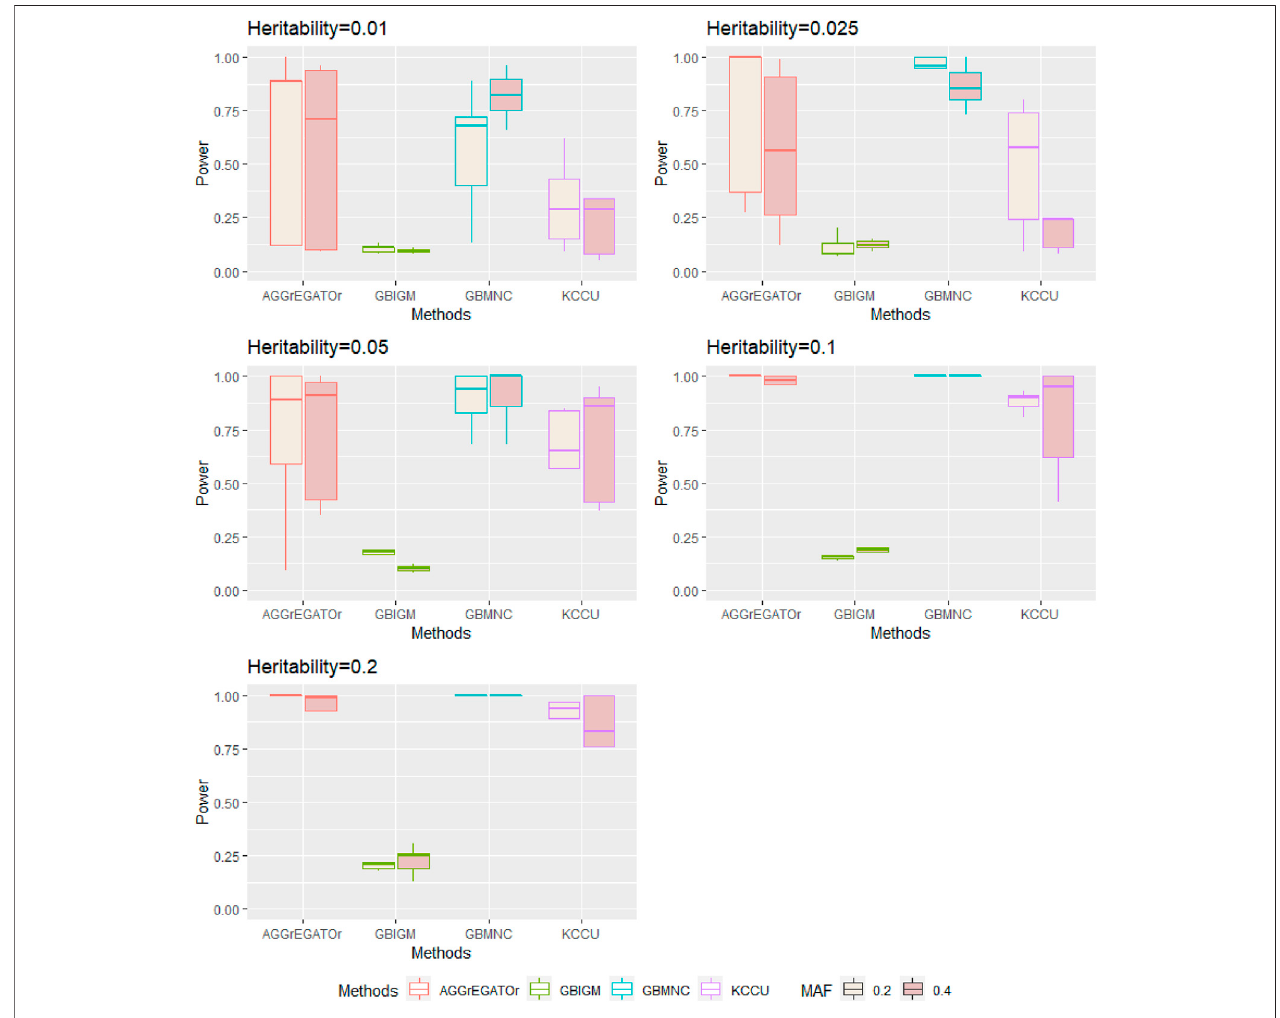
FIGURE 2 | Illustration of the distribution of power of each method in each heritability-MAF combination with h ∈ { 0 . 01 , 0 . 025 , 0 . 05 , 0 . 1 , 0 . 2 } and MAF ∈ { 0 . 2 , 0 . 4 } .